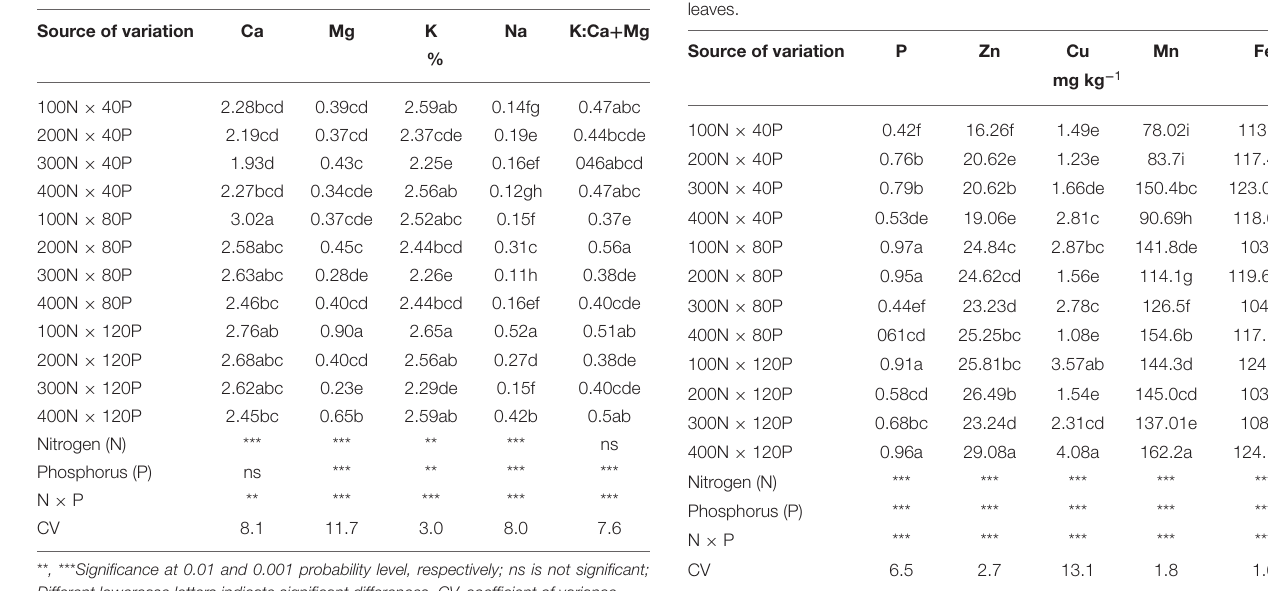
TABLE 4 | Effect of nitrogen and phosphorus on concentrations of minerals in moringa leaves.